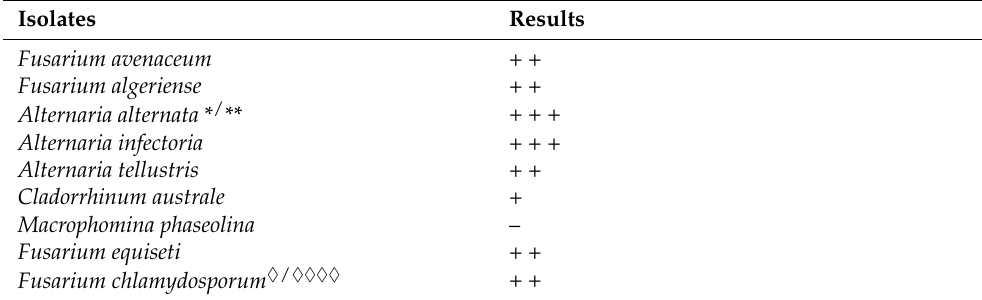
Table 2. Result of cellulase test on isolated endophytic strains in roots of Triticum durum. Isolates